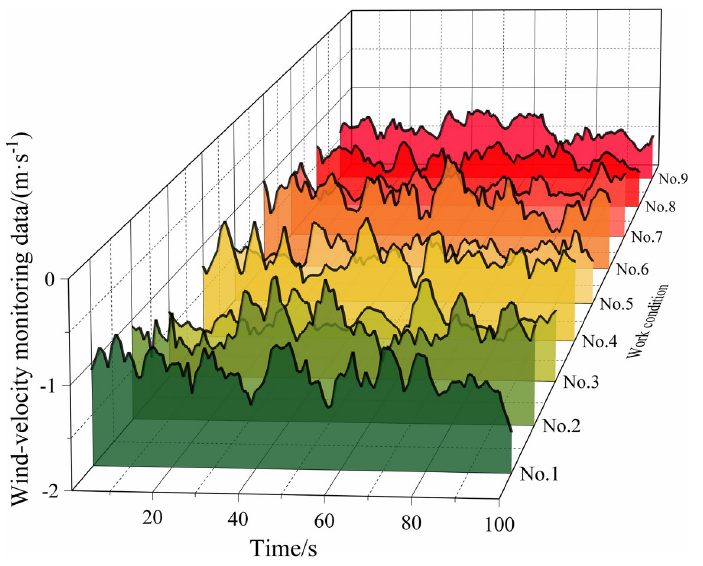
Fig 12. Wind-velocity data recorded at monitoring Point